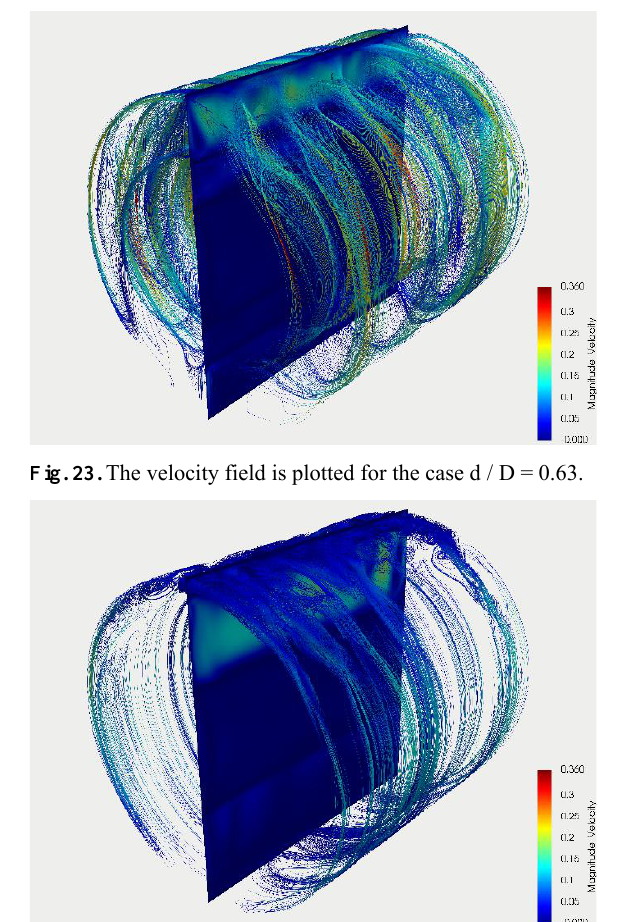
Fig. 22. The velocity field is plotted for the case d / D = 0.5 .